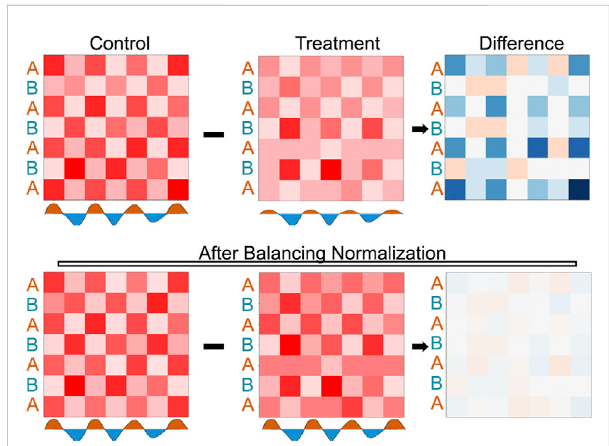
FIGURE 6 Demonstrationofhowmatrixbalancing canobscurewidespread changes. Top row: An example checkerboard matrix (control) where the signal along the A compartment becomes decreased (treatment), the differences shown by the intensity of blue signal on the right (difference). Bottom row: The same checkerboards and the differences after matrix balancing.